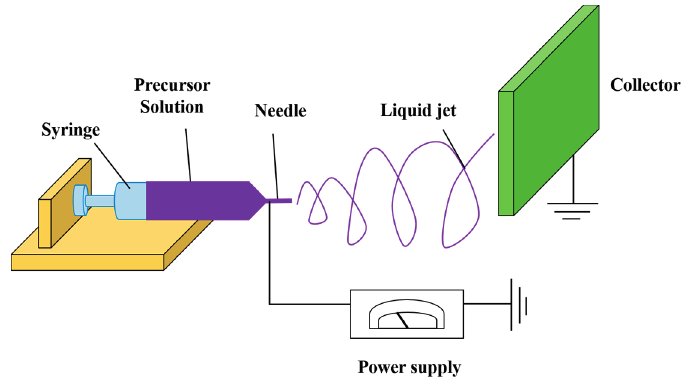
Figure 2. Schematic representation of the ES setup showing arrangement for syringe, precursor solution, needle, liquid jet, collector, and a power supply.